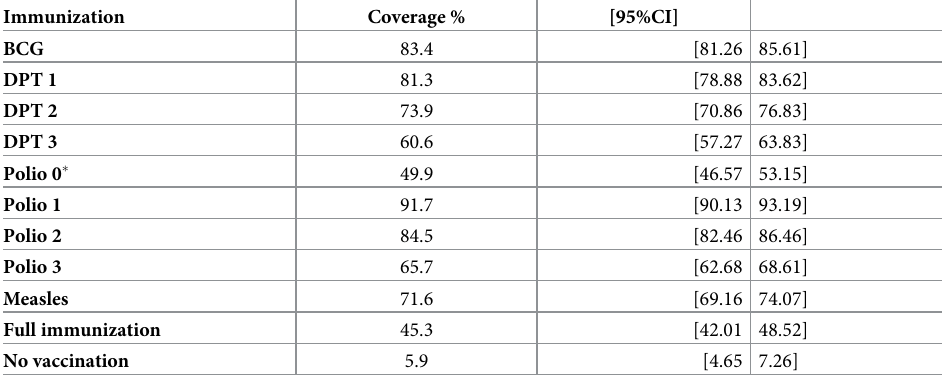
Table 1. Status of child immunization coverage in the DRC in 2013–14 ( n =